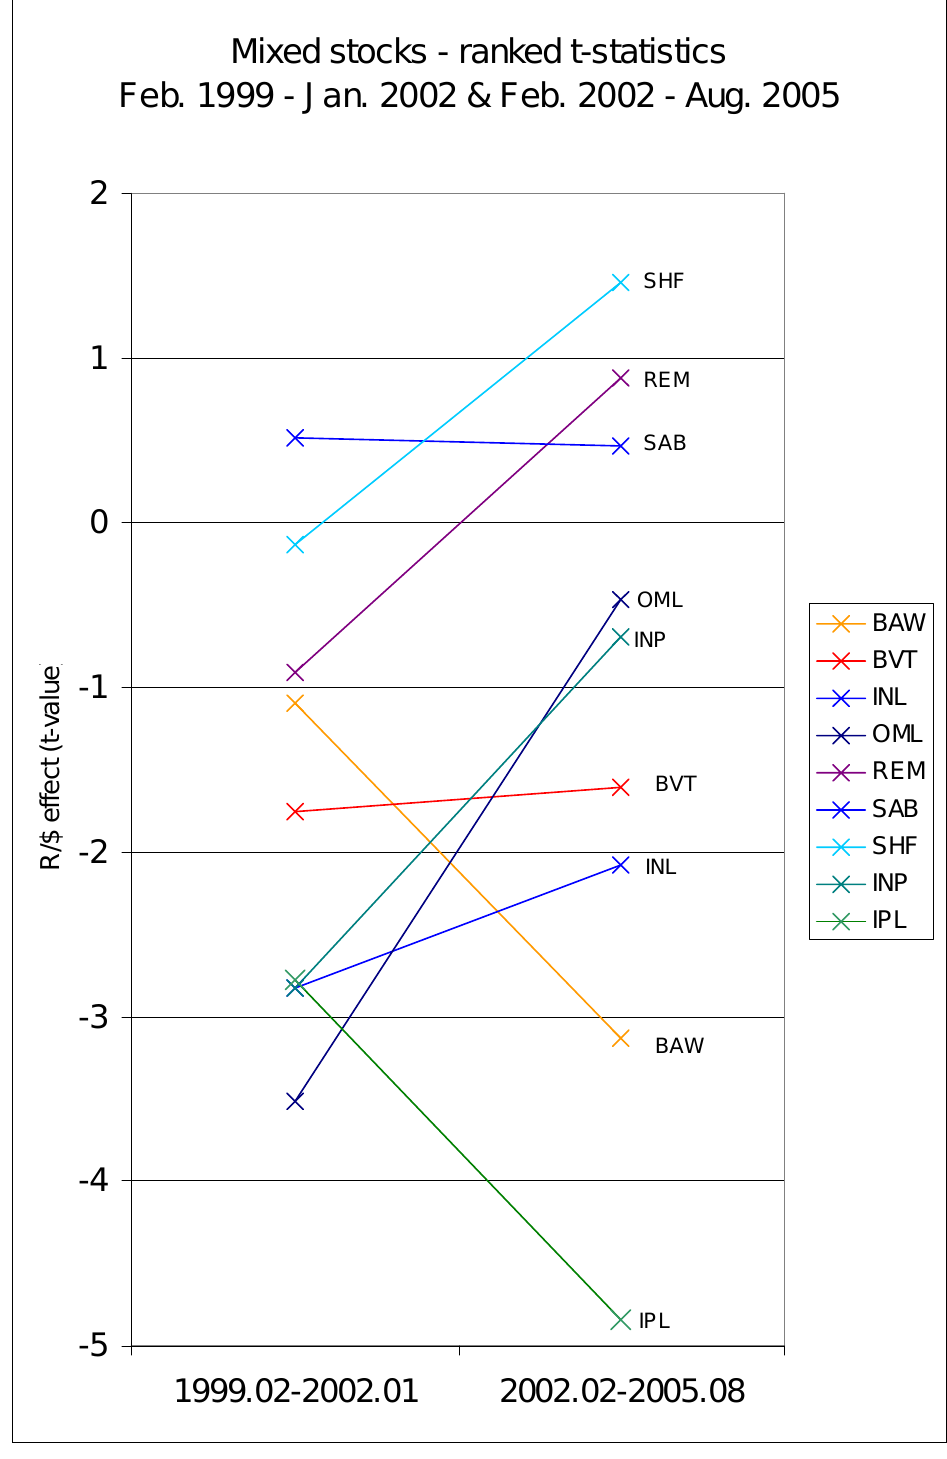
Figure 2: Mixed stocks: Comparing the ranking of the Rand Exchange rate effect (t-statistic) over the periods